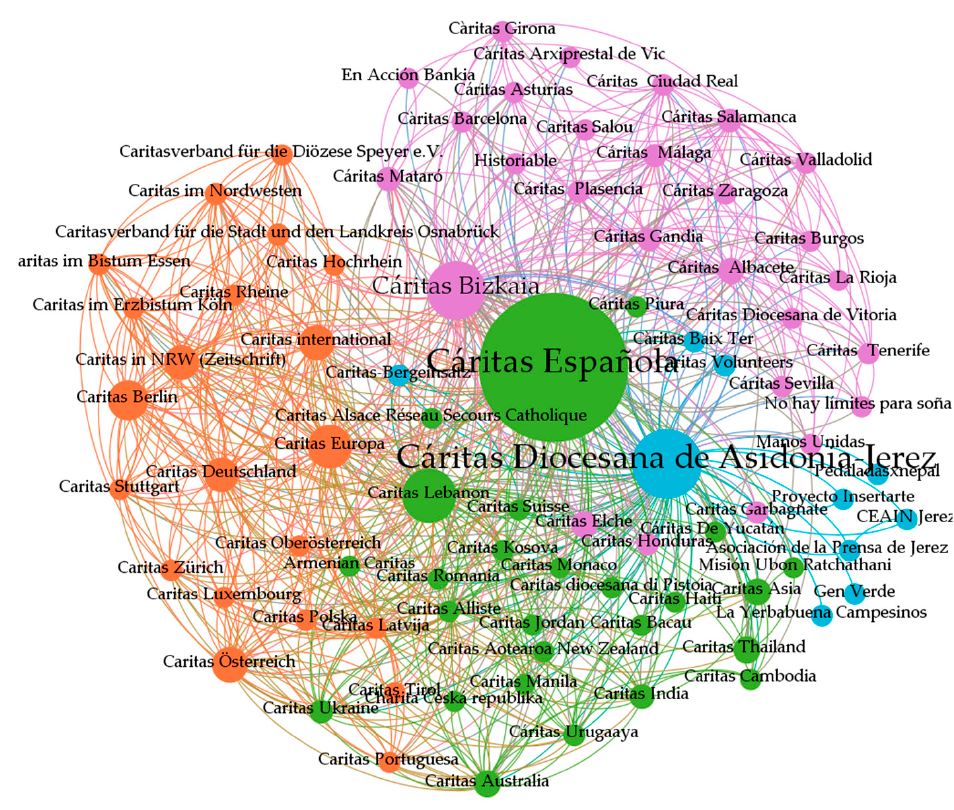
Figure 2. Display of Cáritas Asidonia Jerez’s interest groups on Facebook. Four communities are shown in Figure